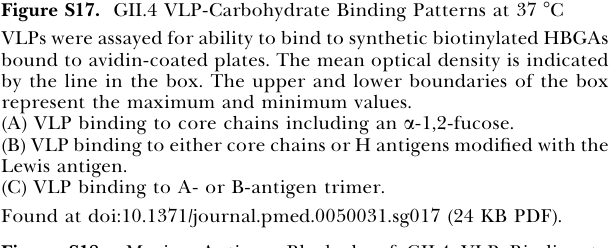
Figure S1. Figure S2. Bayesian Tree of the Full-Length Capsid Node confidences are marked as posterior probabilities. Figure S3. MEGA4.0 MP Tree of the Full-Length Capsid Bootstrap analysis was conducted with 100 replicates. Nodes with less than 50/100 bootstrap support were collapsed. Found at doi:10.1371/journal.pmed.0050031.sg003 (21 KB PDF). Figure S4. PAUP4.0b10 MP Tree of the Full-Length Capsid Node confidences are shown as percent present in equally parsimo- nious trees. Found at doi:10.1371/journal.pmed.0050031.sg004 (24 KB PDF). Figure S5. Bayesian Tree of the Shell Domain Node confidences are marked as posterior probabilities. Found at doi:10.1371/journal.pmed.0050031.sg005 (62 KB PDF). Figure S6. MEGA4.0 MP Tree of the Shell Domain Bootstrap analysis was conducted with 100 replicates. Nodes with less than 50/100 bootstrap support were collapsed. Found at doi:10.1371/journal.pmed.0050031.sg006 (20 KB PDF). Figure S7. PAUP4.0b10 MP Tree of the Shell Domain Node confidences are shown as percent present in equally parsimo- nious trees. Found at doi:10.1371/journal.pmed.0050031.sg007 (23 KB PDF). Figure S8. Bayesian Tree of the P1 SubdomainNode confidences are marked as posterior probabilities. Found at doi:10.1371/journal.pmed.0050031.sg008 (61 KB PDF). Figure S9. MEGA4.0 MP Tree of the P1 Subdomain Bootstrap analysis was conducted with 100 replicates. Found at doi:10.1371/journal.pmed.0050031.sg009 (19 KB PDF). Figure S10. PAUP4.0b10 MP Tree of the P1 SubdomainNode confidences are shown as percent present in equally parsimonious trees. Figure S11. Bayesian Tree of the P2 Subdomain Node confidences are marked as posterior probabilities. Found at doi:10.1371/journal.pmed.0050031.sg011 (63 KB PDF). Figure S12. MEGA4.0 MP Tree of the P2 Subdomain Bootstrap analysis was conducted with 100 replicates. Nodes with less than 50/100 bootstrap support were collapsed. Found at doi:10.1371/journal.pmed.0050031.sg012 (21 KB PDF). Figure S13. PAUP4.0b10 MP Tree of the P2 Subdomain